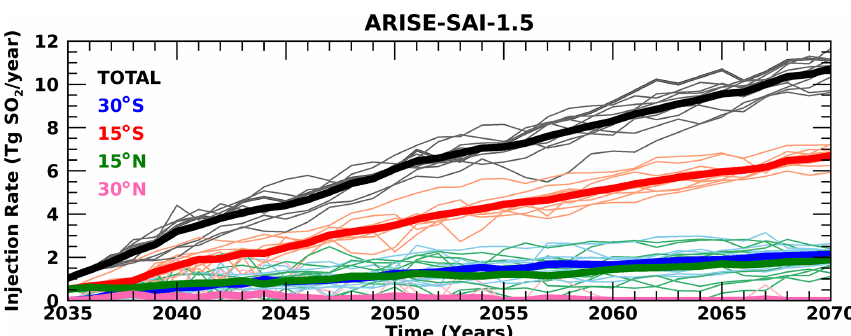
Figure 1. SO 2 injection rate as a function of time in ARISE-SAI-1.5 simulations at 30 ◦ S (blue), 15 ◦ S (red), 15 ◦ N (green), 30 ◦ N (pink), and total (black). Thin lighter-colored lines represent individual ensemble members, whereas thick lines show the 10-member ensemble mean.